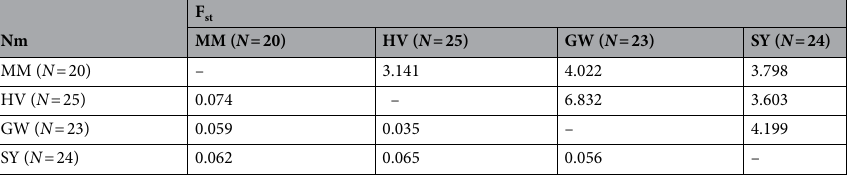
Table 5. Pairwise F st and Nm among four populations (MM, HV, GW, SY) of Chamaecyparis formosensis using 36 simple sequence repeat (SSR) data. N: the number of individuals; F st : the fixation index. F st < 0.05, no differentiation among populations. 0.05 < F st < 0.15, low differentiation among populations. Nm: the gene flow value. Nm > 1 represents the frequent exchange of genes, which counteracts the genetic drift and prevents the population differentiation 48 . When Nm is greater than 4, it would be a random mating population 49